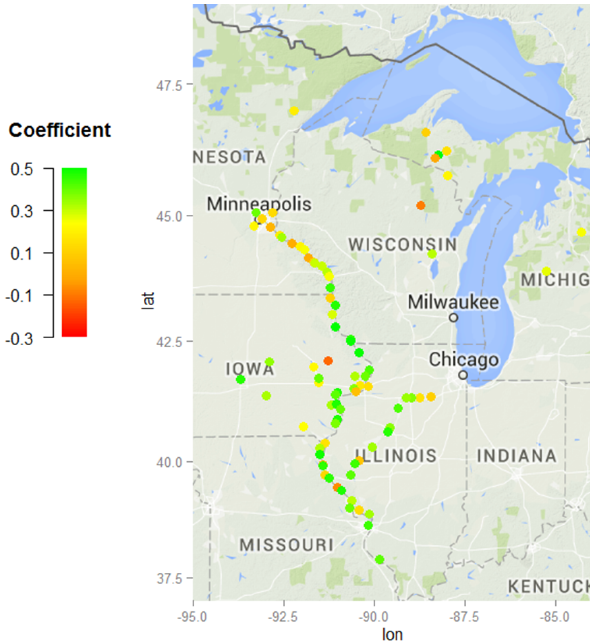
Figure 20. Geographical position of rivers. Colors indicate the re- gression coefficient of each station with the Brier skill score as de- pendent variable.